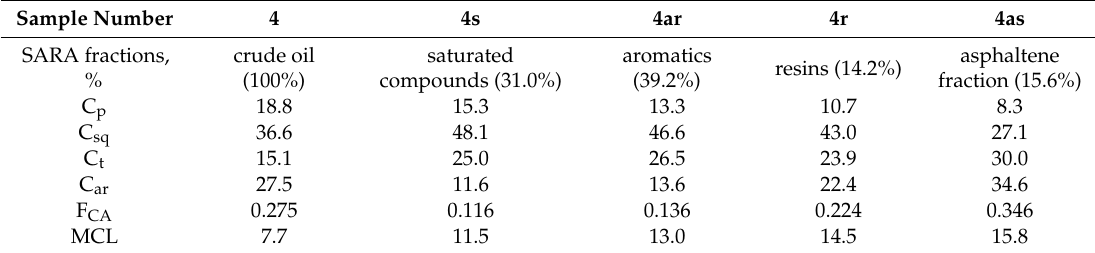
Figure 5. 13 C (175 MHz) NMR spectra of oil samples 4s–4as (s—saturated compounds, ar—aromatics, r—resins, as—asphaltene fraction). Table 8. Molar fractions (%) of primary (C p ), secondary and quaternary (C sq ), tertiary (C t ), aromatic (C ar ) groups, aromaticity factor (F CA ), and mean chain length (MCL) of aliphatic hydrocarbons based on 13 C NMR spectra of samples 4, 4s–4as.